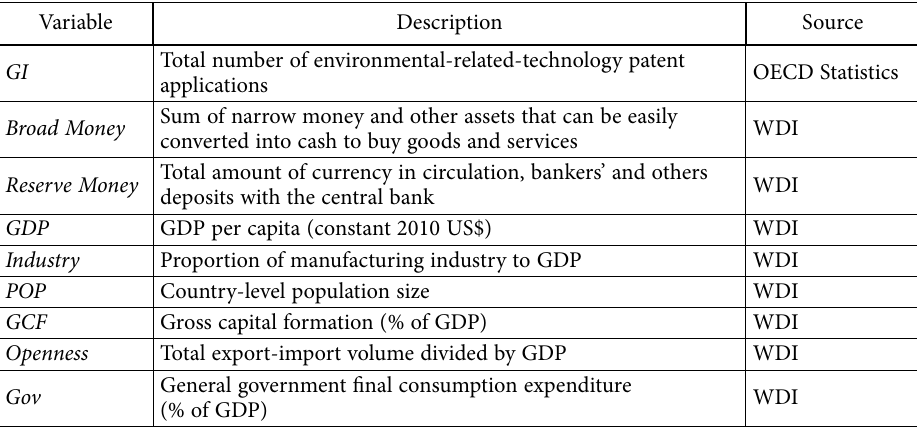
Table 1. Variable descriptions and